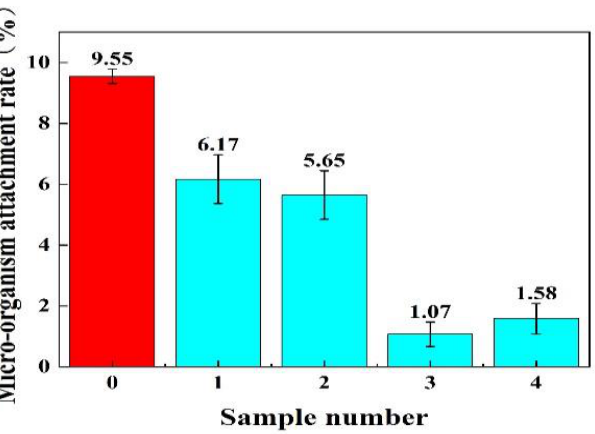
Figure 5. Micro-organism attachment rates of specimens No. 0 – 4.